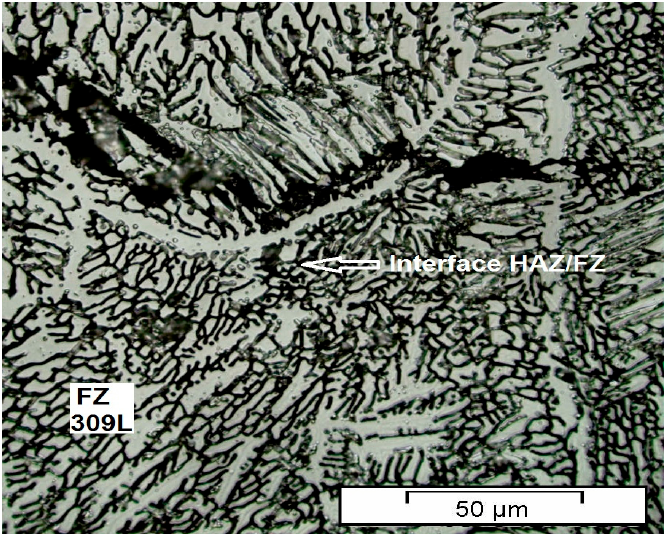
Figure 8. Microstructure showing the presence of a semi-continuous delta ferrite network in the fusion zone of the dissimilar weldment with 309L weld metal.